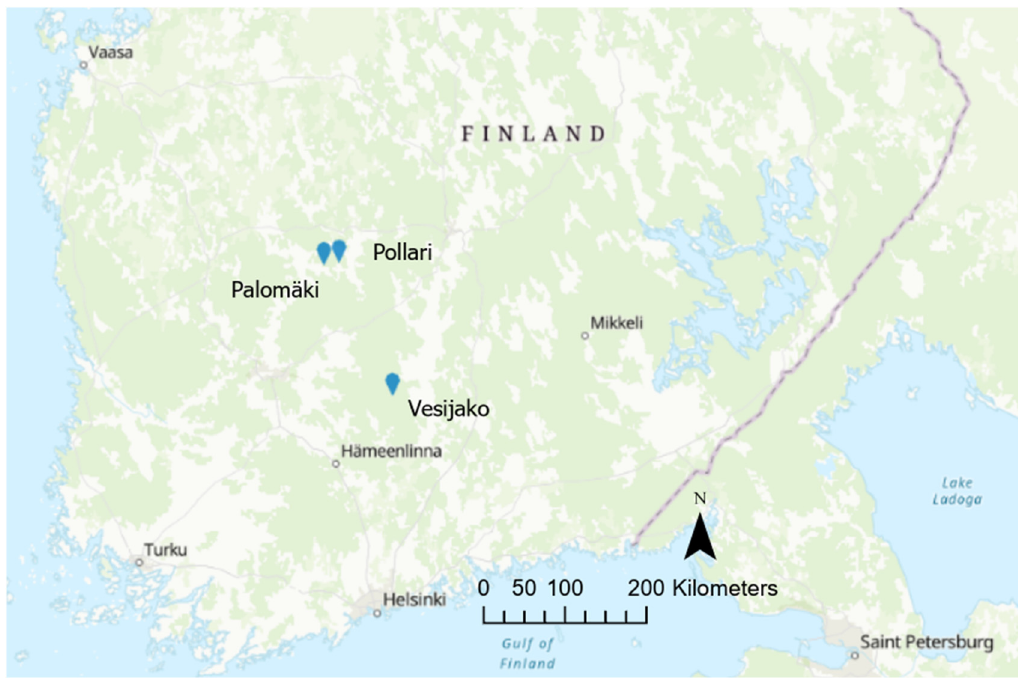
Figure 2. Location of the study sites: Palomäki, Pollari, and Vesijako. Table 1. Information on the study